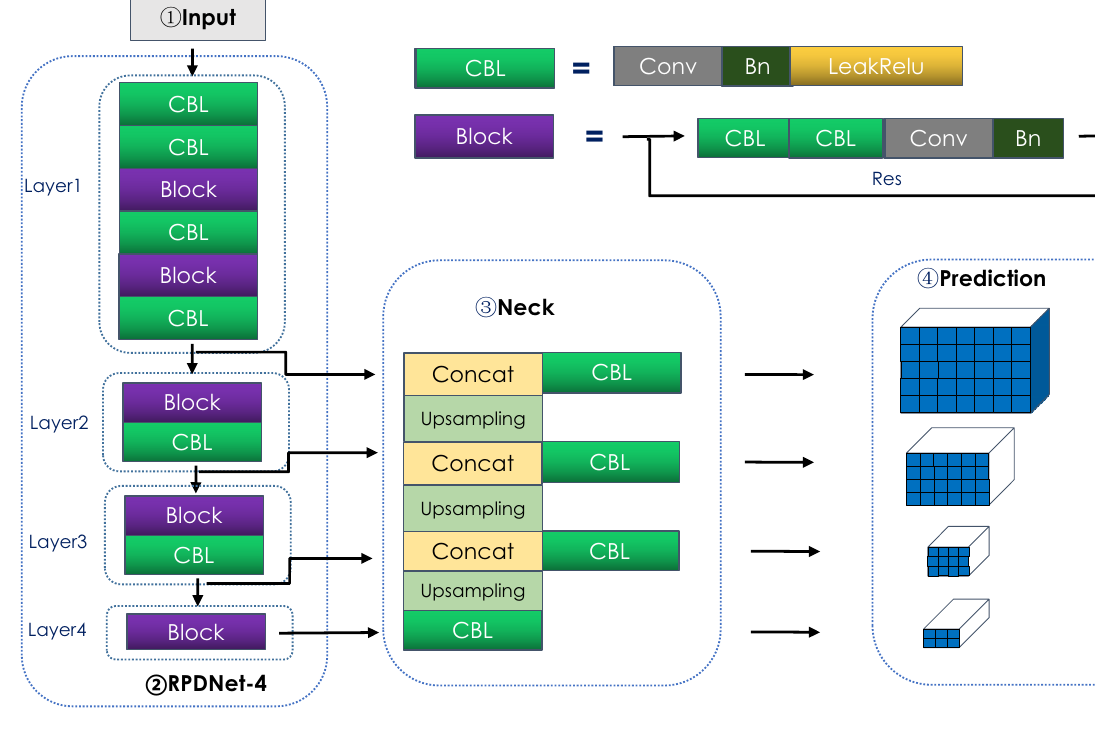
Figure 1. RPD detection framework.